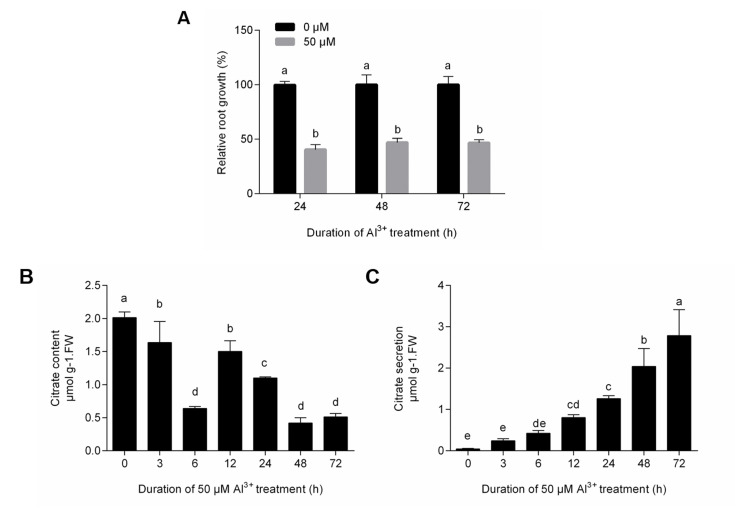
Effect of the Al3+ treatment on TBS roots.(A) Relative root growth; (B) Citrate content; (C) Citrate secretion. The bars are the means ± standard deviation of three replicates. Different letters above columns indicate significance (Duncan, p < 0.05).